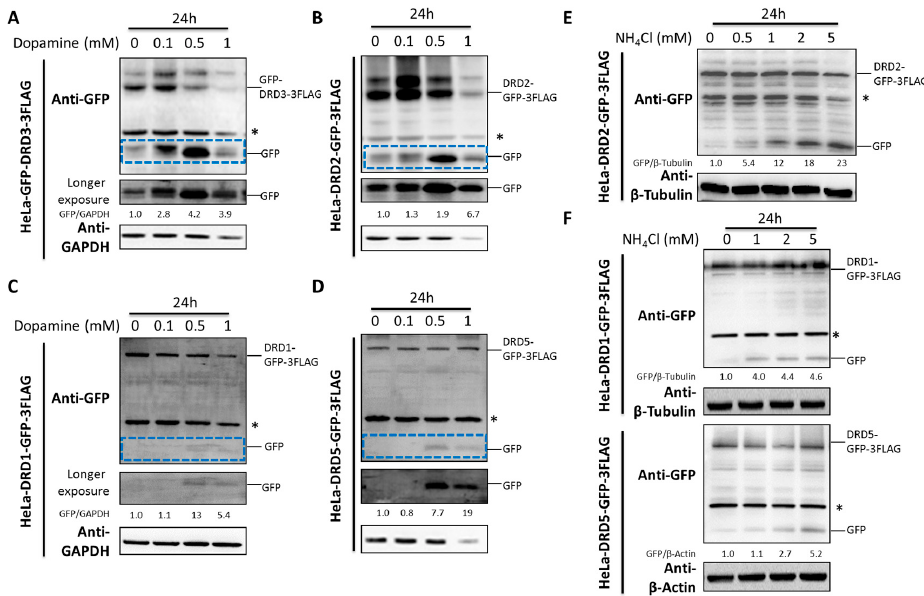
Figure 3. Dopamine and ammonia induce the degradation of D1-like and D2-like dopamine receptors differentially. ( A – D ) HeLa cells stably expressing GFP-3FLAG tagged DRD1, 2, 3 and 5 were treated with different concentrations of dopamine for 24 h. ( E – F ) HeLa cells stably expressing GFP-3FLAG tagged DRD1, 2 and 5 were treated with different concentrations of ammonia for 24 h. The asterisk (*) indicates the nonspecific band. Experiments were repeated at least three times and representative Western blots are shown. Blue dashed frames show the GFP fragment with shorter exposure. Densitometric analysis was performed and quantification results were labeled below the corresponding blots.